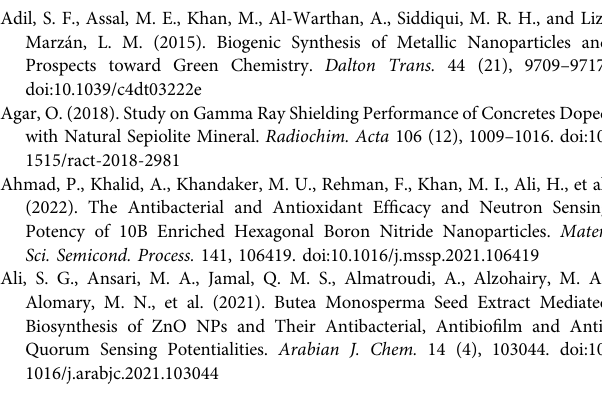
Frontiers in Chemistry |